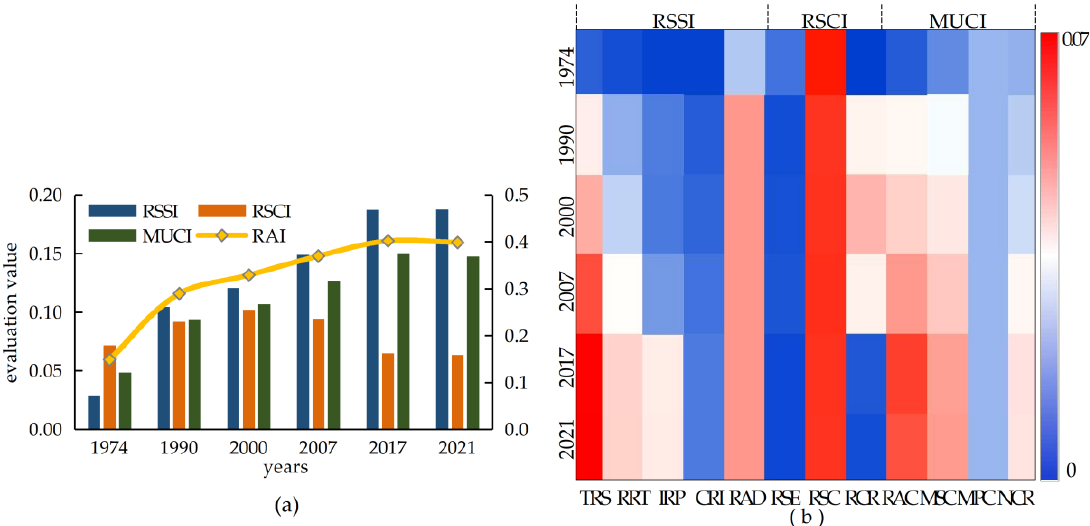
Figure 4. The evaluation results ( a ) and trends of the intensity of reclamation activity (RAI) in the study area ( b ).